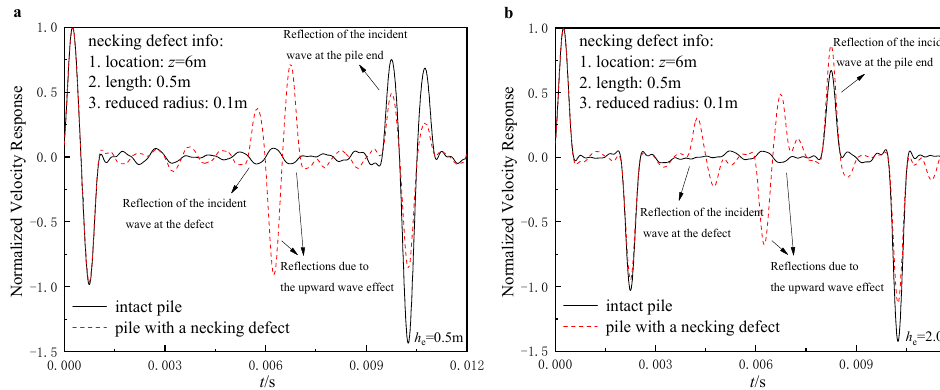
Figure 6. Identification of necking defects through TLSIT: ( a ) h e = 0.5 m; ( b ) h e = 2.0 m.